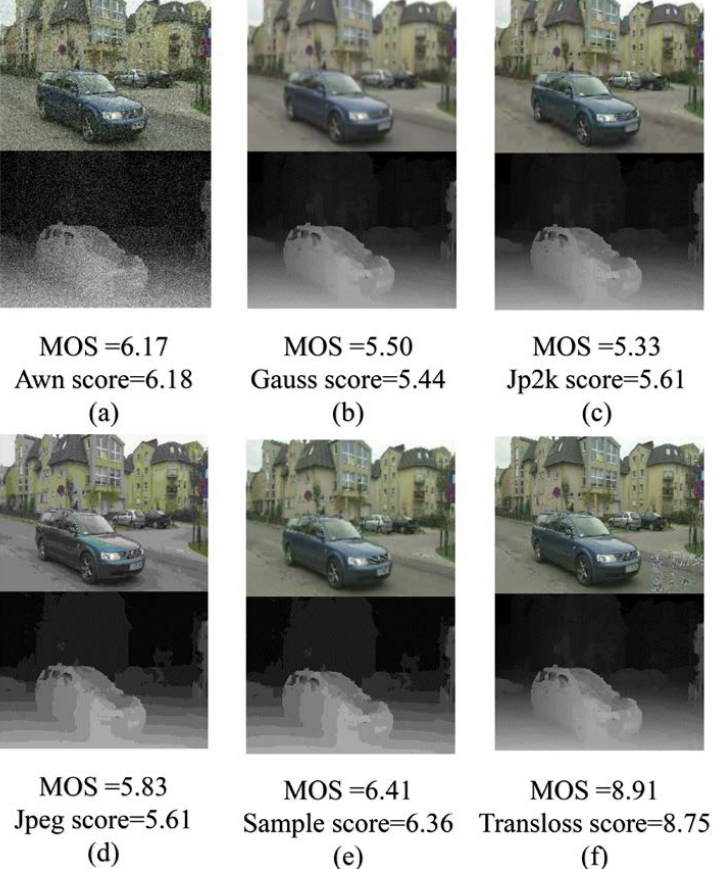
Table 6. Ablation results on the MCL-3D database. The HEDIP is the model proposed in this paper. Figure 8. Texture–depth image pairs for six different distortions; each image pair comes with the MOS value and the predicted score: ( a ) additive white noise; ( b ) Gaussian blur; ( c ) JPEG2000; ( d ) JPEG compression; ( e ) downsampling blurring; ( f ) transmission error.